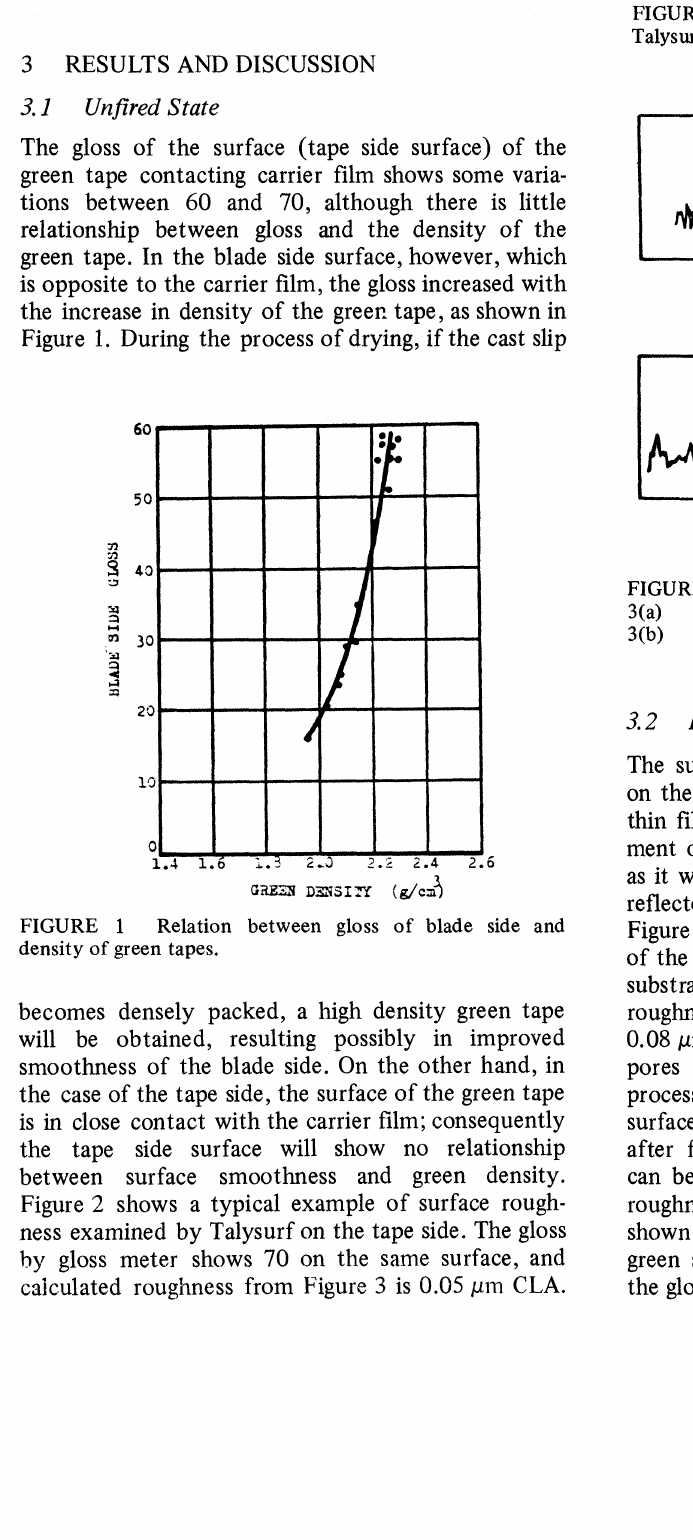
FIGURE 2 Surface roughness of green tapes examined by Talysurf; tape side.